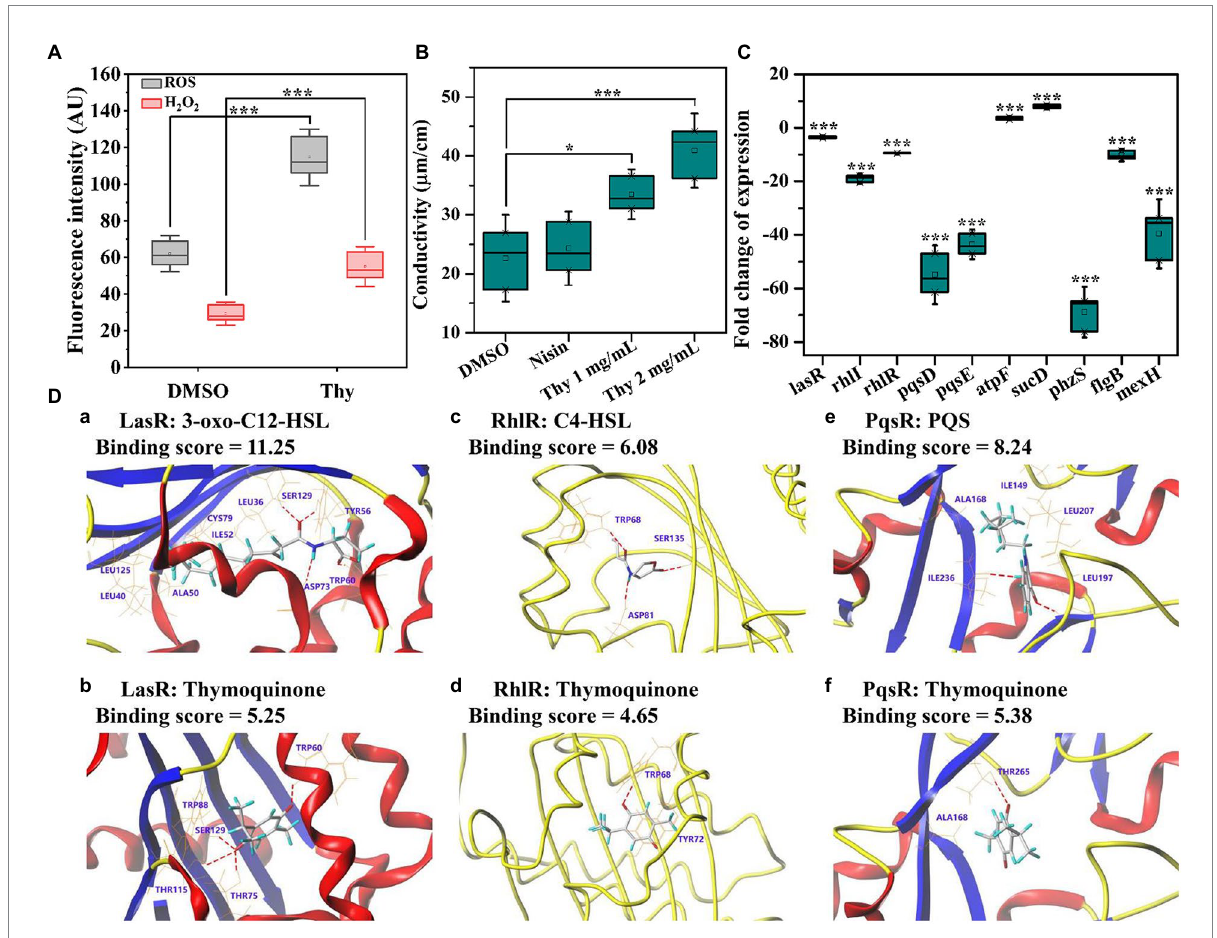
FIGURE 9 Effects of thymoquinone on ROS production, cell membrane permeability, gene expression, and the docking sumulation. (A) ROS and H 2 O 2 production. (B) Membrane permeability. (C) Expressions of genes involved in QS, virulence, energy metabolism, and drug resistance. (D) A 3D schematic of receptor-ligand interactions of LasR (a,b) , RhlR (c,d) , and PqsR (e,f) with 3-oxo-C12-HSL (a) , C4-HSL (c) , PQS (e) , and thymoquinone (b,d,f) , respectively. Statistical differences were determined by ANOVA followed by the Tukey–Kramer test. ( ∗∗∗ ) p < 0.001 versus the DMSO control.